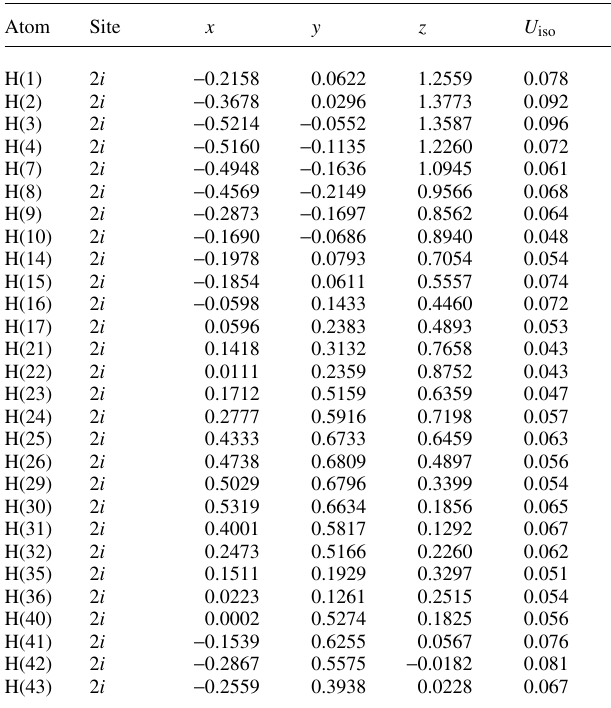
Table 2. Atomic coordinates and displacement parameters (in Å 2 )